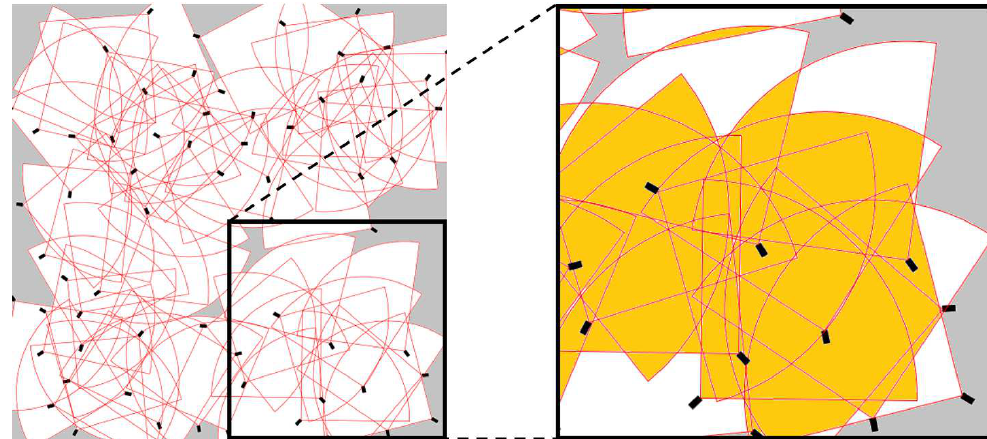
Figure 2. A typical environment semi-randomly generated for the numerical experiment setup. Colour as in Figure 1: the zoomed-in picture on the right shows overlap (orange area) if all cameras are turned on. Note the “blind spots” (grey area) that are permanently outside coverage.